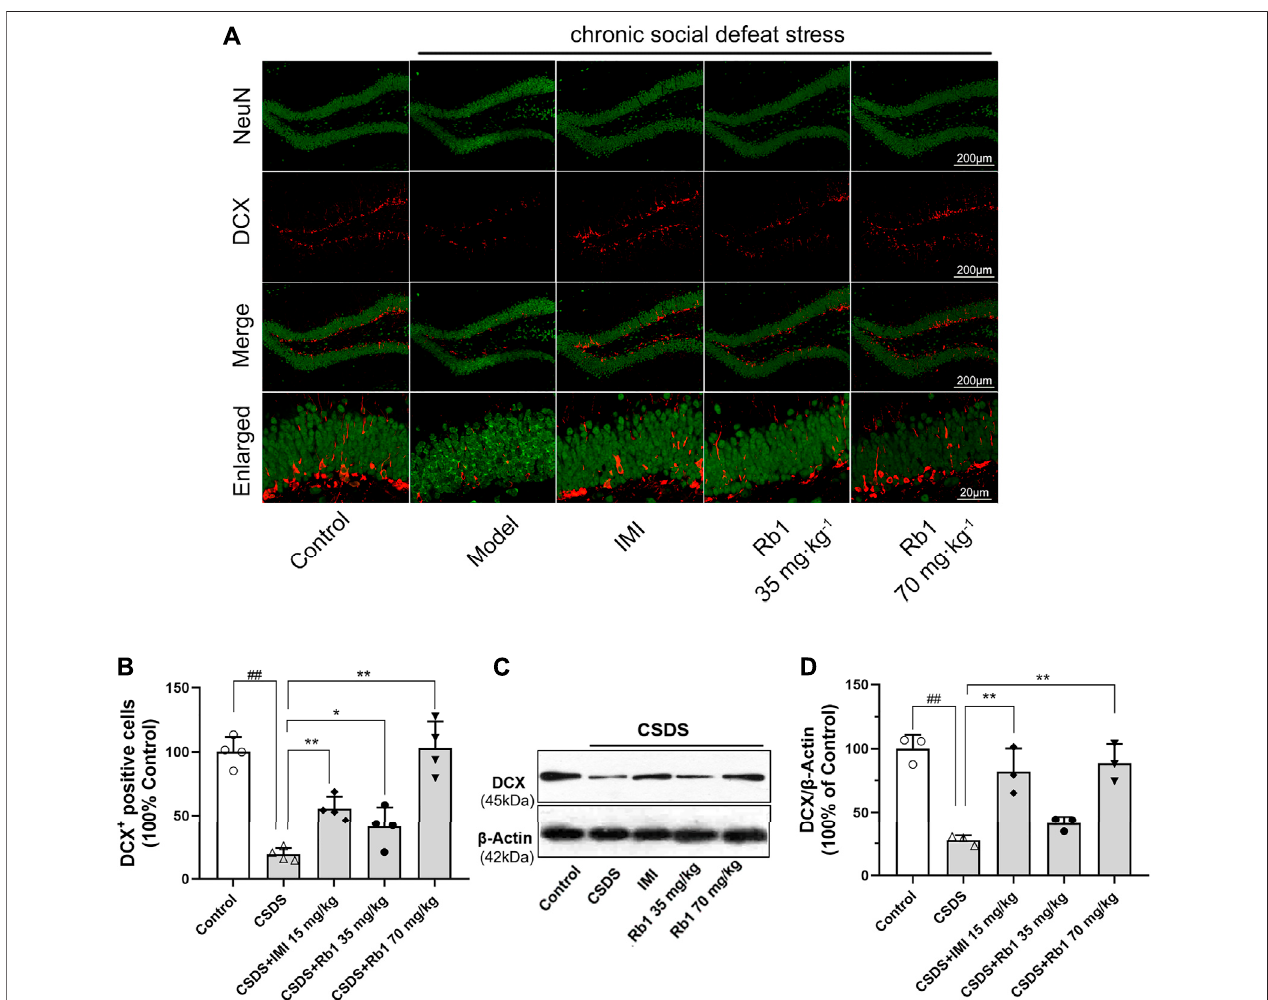
FIGURE 3 | Rb1 treatment improved the hippocampal neurogenesis in the CSDS depression model. (A) Representative immuno fl uorescence images of the dentate gyrus (DG) and costaining of the neuronal nuclear protein (NeuN) and DCX in green. The scale bar is 200 and 20 μ m for the representative and the enlarged images, accordingly. (B) The number of DCX + cells in the DG. (C – D) Represents immunoblotting of DCX coincided with immunohistochemical changes. N (cid:2) 3 – 4 per group, the obtained data have been depicted as the mean ± S.E.M. ## p < 0.01, vs. the control group; * p < 0.05, ** p < 0.01, vs. the model